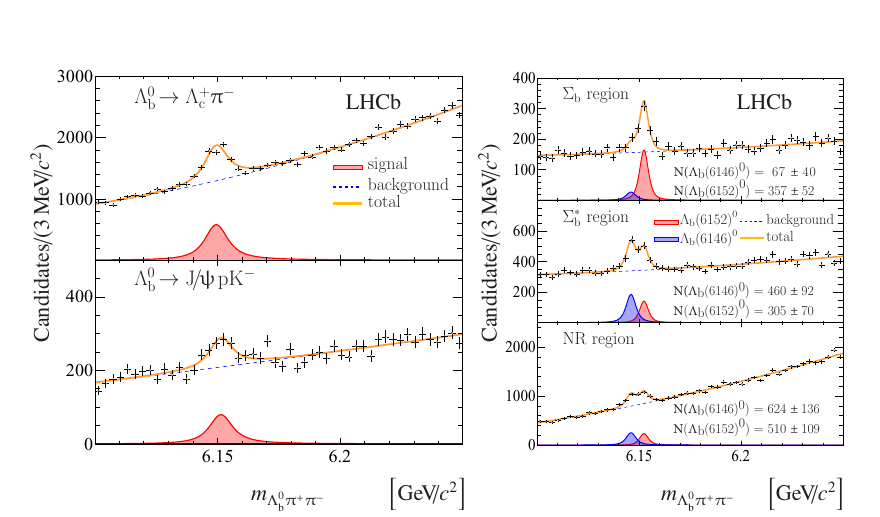
(cid:30) Λ + π − and (bottom) c b → π + π − candidates for the three regions in b